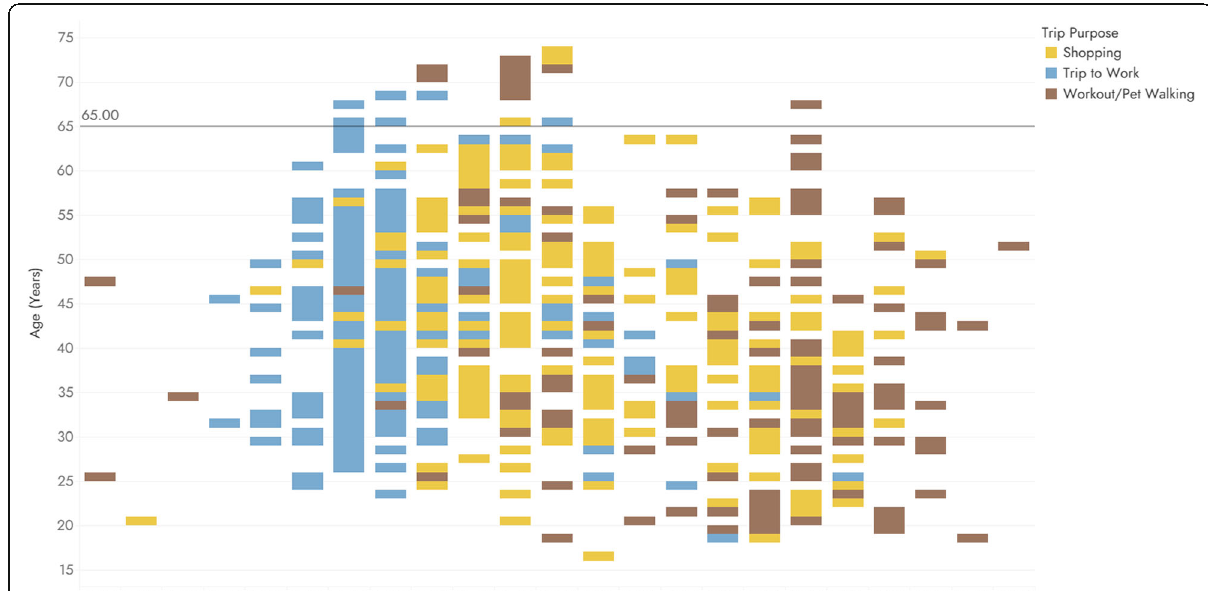
Fig. 5 Trips throughout the day per trip purpose in relation to